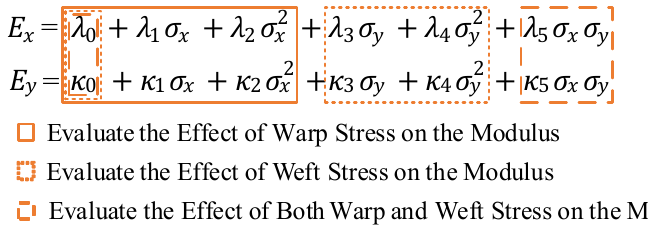
Figure 1. Significance of each monomial term.